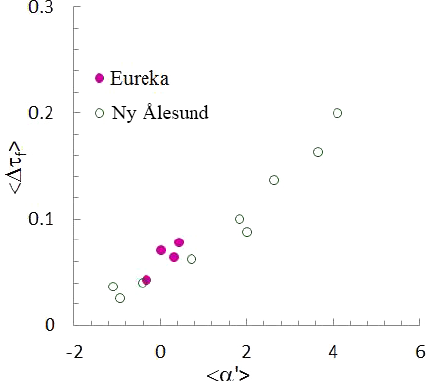
Figure B1. Variation of the monthly averaged error in the SDA fine- mode AOD ( < (cid:49)τ f >) as a function of the monthly averaged spec- tral curvature ( < α (cid:48) > , the second derivative of the spectral AOD; cf. O’Neill et al., 2003, for details). These monthly averages were computed using individual measurements rather than daily averages (and thus (cid:49)τ f and α are not in